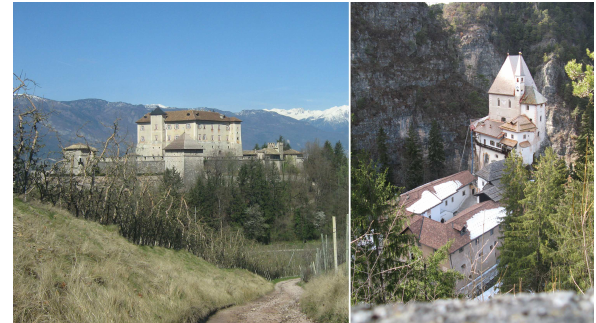
Figure 1. Thun Castle and S. Romedio sanctuary in Non